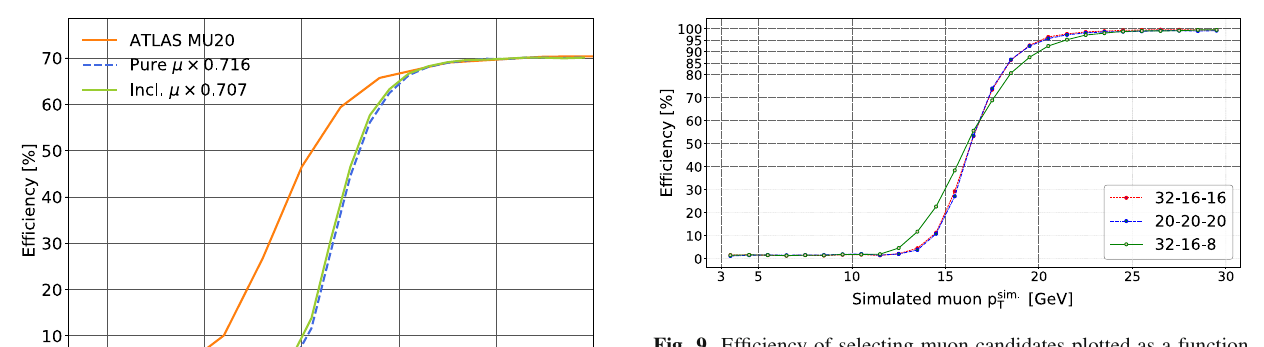
Fig. 9 Efficiency of selecting muon candidates plotted as a function of the muon p T for three different neural network